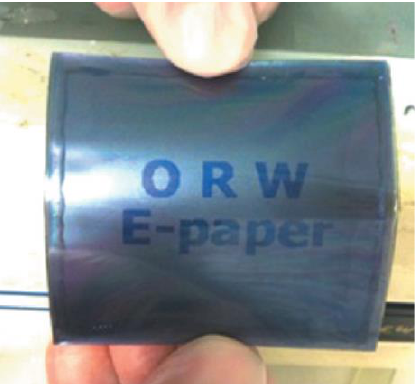
Figure 6. Recorded sample image on flexible ORW e-paper.